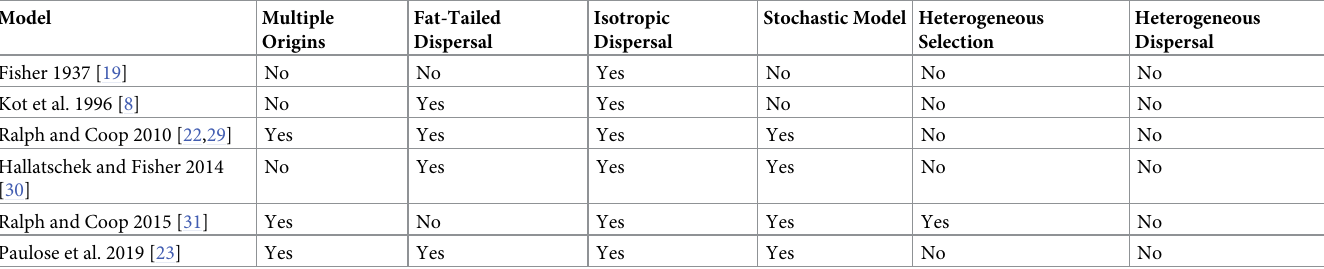
Table 1. Comparison of reviewed forward-in-time spatial population genetics